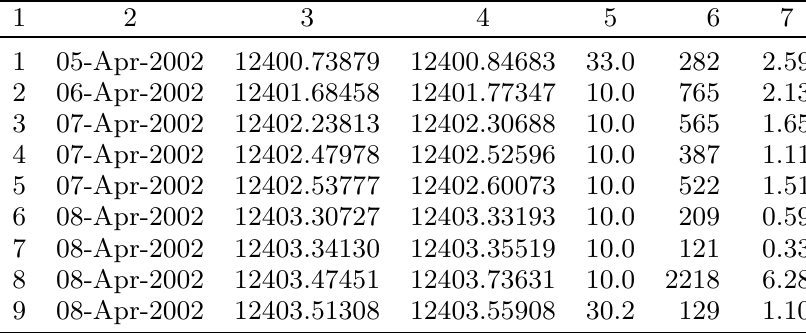
Table 4. Journal of observations of